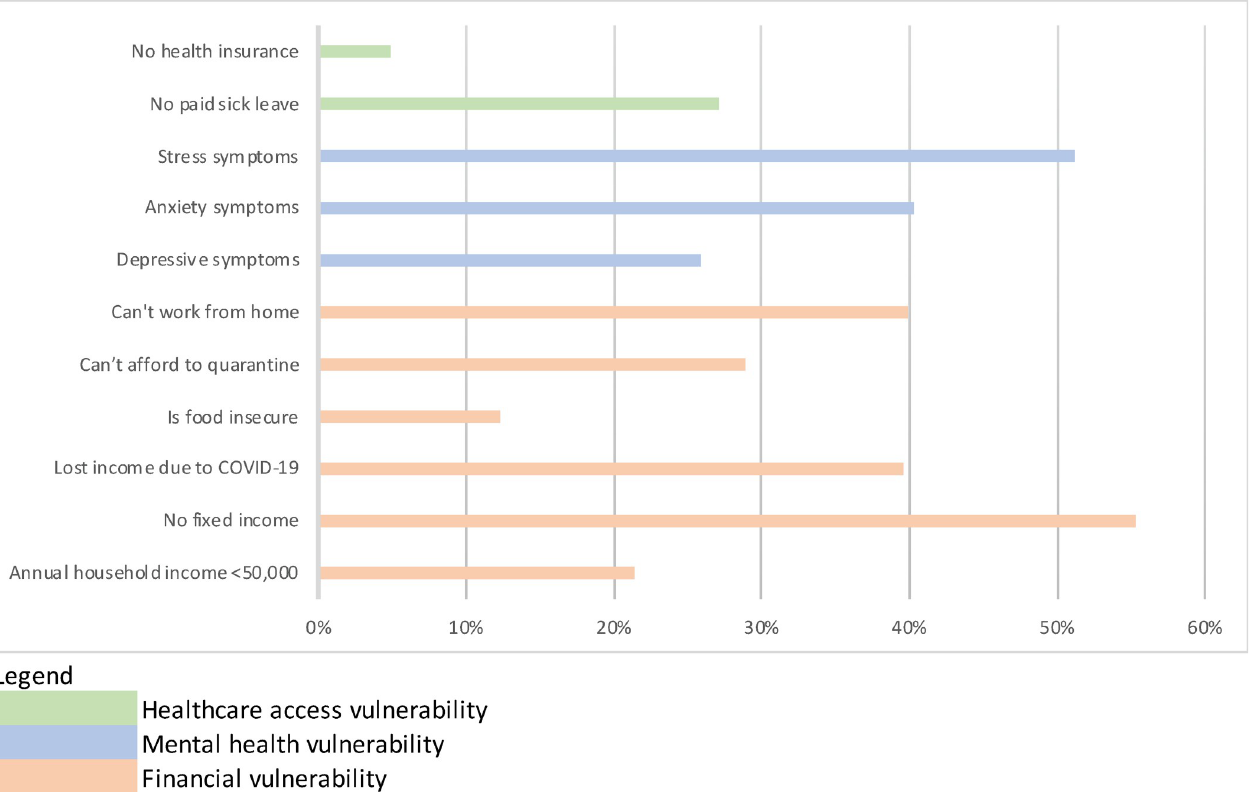
Fig 2. Cumulative distribution of factors among 2,845 U.S. workers during the COVID-19 pandemic (April